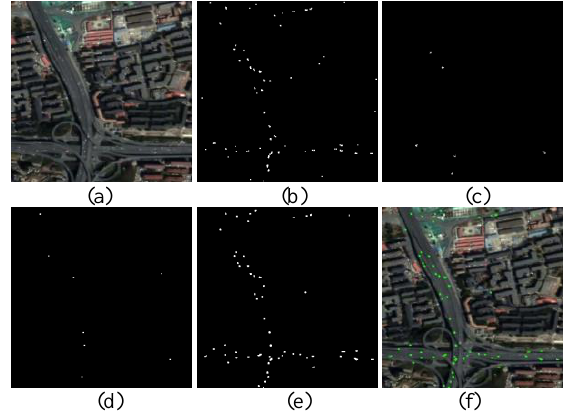
Figure. 6 Original data and all kinds of detection results of